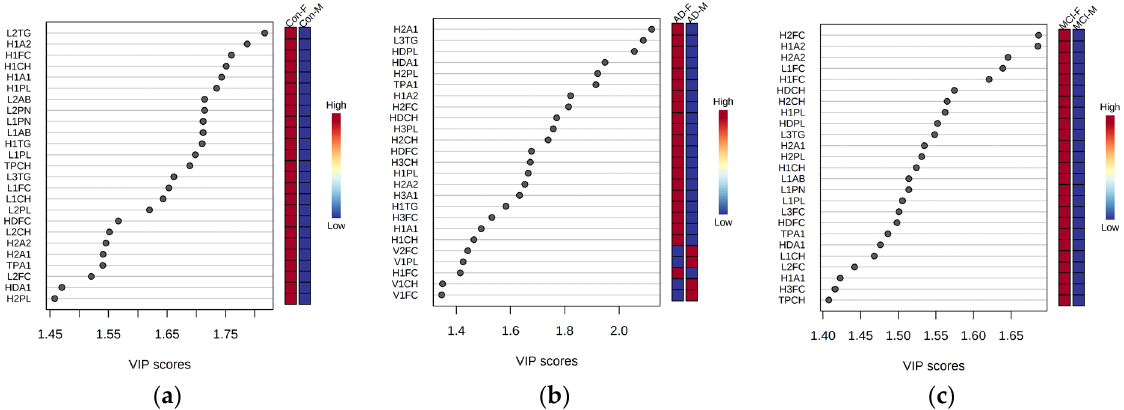
Figure A2. Multivariate analysis of the three male-female group comparisons based on oPLS-DA (Panel a, in the cognitively control group; Panel b, AD patients; Panel c, MCI patients). The score plots include the top-25 lipoprotein variables ranked by the highest importance score. F–female. M–male.